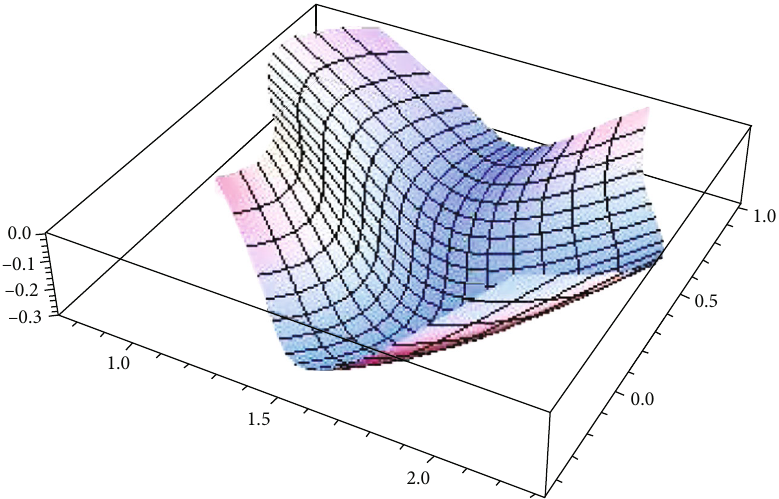
Figure 11: Bicubically blended Coons patch chosen as the initial